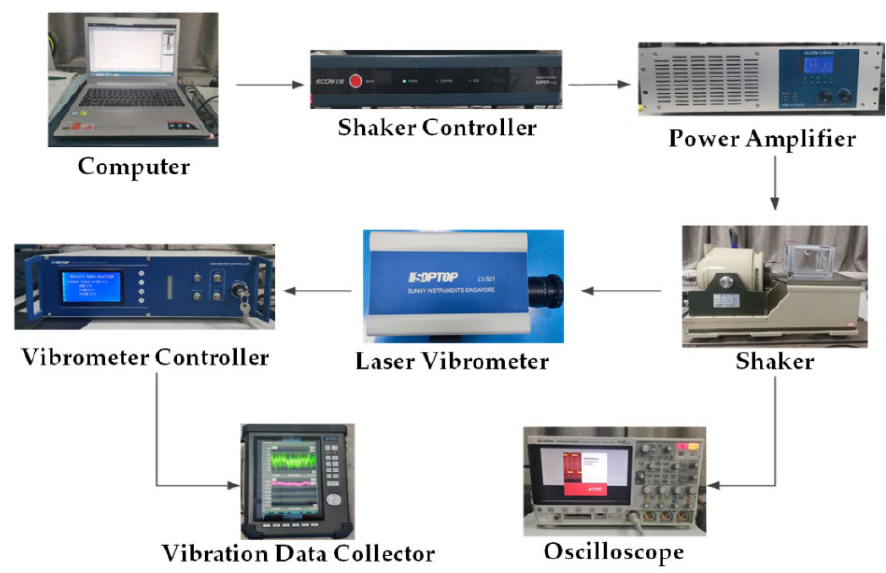
Figure 14. Experimental test platform.